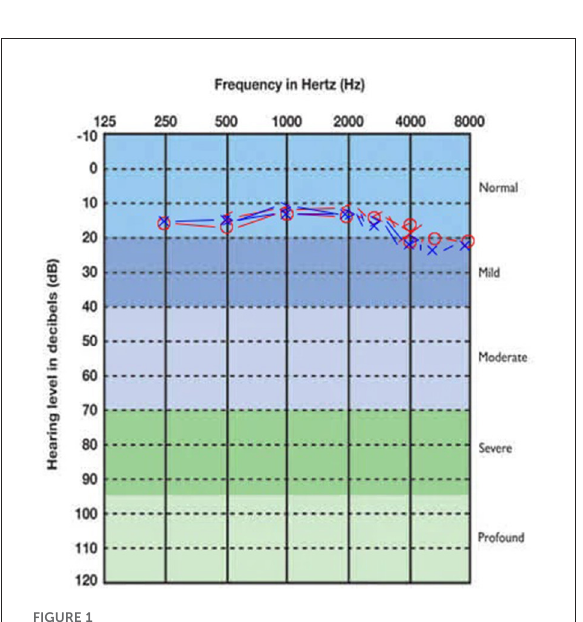
FIGURE1 Average audiogram of NT group patients. Right ear thresholds in red, left ear in blue.